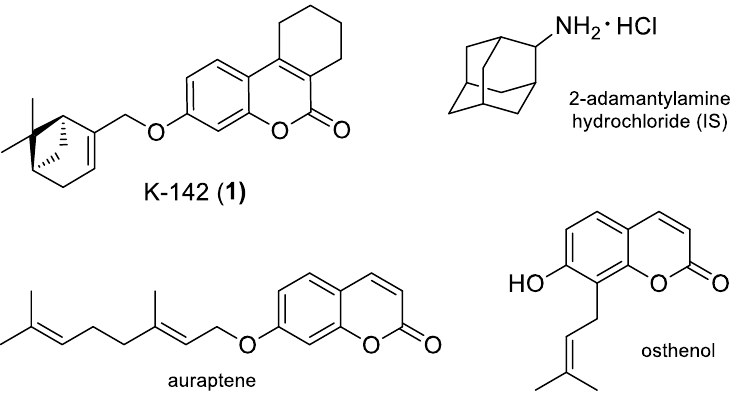
Figure 1. Chemical structures of K-142 (compound 1 ), 2-adamantylamine hydrochloride (internal standard, IS) and bioactive coumarin derivatives auraptene and osthenol.